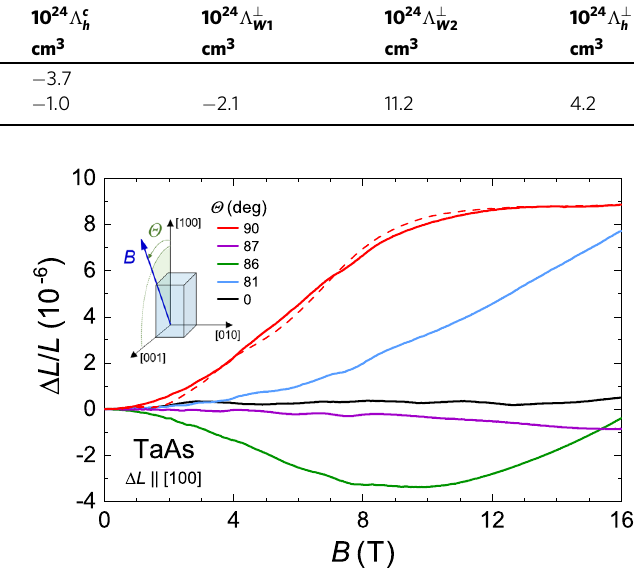
Fig. 6 Angle-dependent magnetostriction of TaAs measured along the a axis. Magnetic- fi eld dependence of the relative length change Δ L / L of TaAs (sample 2) is measured along the [100] direction at 25 mK for various angles Θ between the direction of B and the a axis. The magnetic fi eld lies in the plane (010). Note the exceptional changes of Δ L / L over the small-angle range near Θ = 90 ∘ . (The corresponding results for Θ ≤ 45 ∘ are shown in Supplementary Fig. 3). The dashed red line shows the a -axis magnetostriction that is calculated at T = 0 for the fi eld aligned with the c direction, using F W 1 = 7.2 T, F W 1 = 1.35 T, γ W 1 = 0.1 and γ W 2 = 0.2 (Supplementary Note